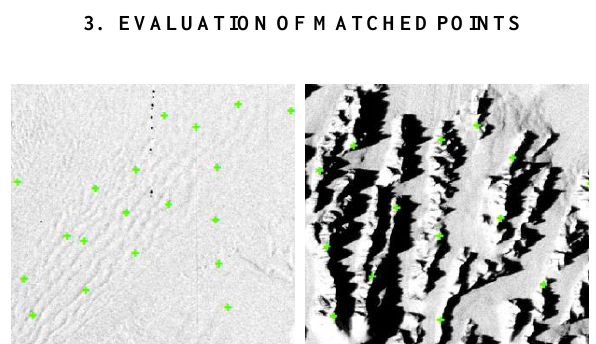
Figure 3. ARGON image draped on the DEM